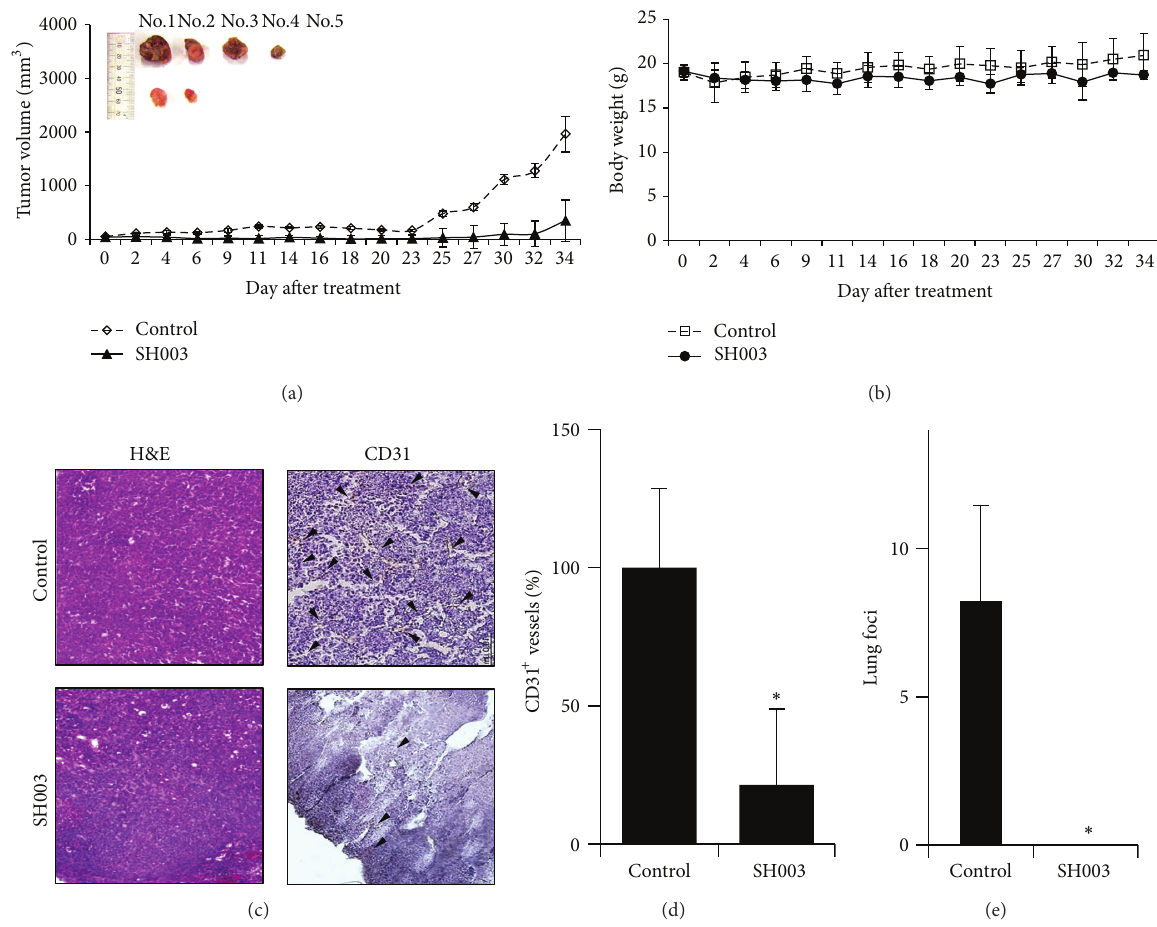
Figure 2: SH003 suppresses tumor growth in vivo . (a) 1 × 10 6 MDA-MB-231 cells were s.c. injected and nude mice ( 𝑛 = 5 /group) were p.o. administrated with the indicatives until 34 days. Xenograft tumor volumes were measured three times a week by a caliper. ∗ 𝑃 < 0.05 . (b) Body weights were measured three times a week. (c) Tumor tissues were stained with hematoxylin and eosin. Photo images were taken at 20x magnification. Tumor tissues were also stained with anti-CD31 antibody to detect tumor angiogenic vessels. The bar indicates 10 𝜇 m. (d) To measure tumor angiogenic vessels in tumor cohorts, CD31-positive vessels were counted. ∗ 𝑃 < 0.05 . (e) Pulmonary metastases were determined by counting foci at